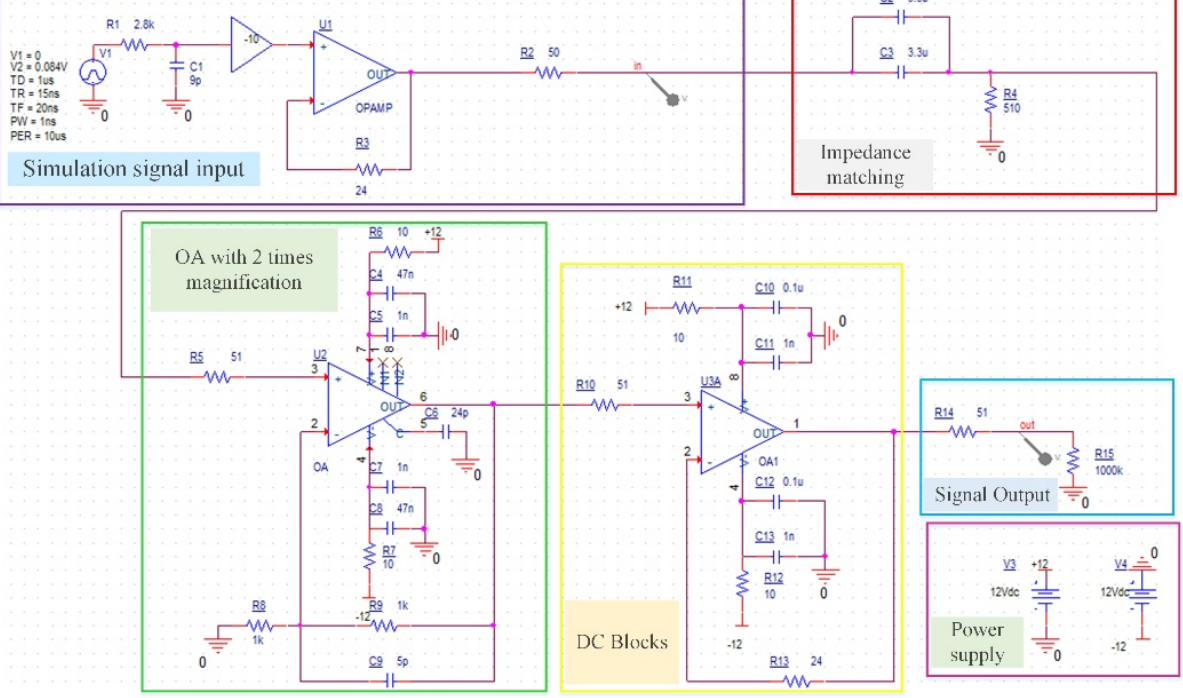
Figure 8. The simulation of the airborne prototype ACB at magnification of